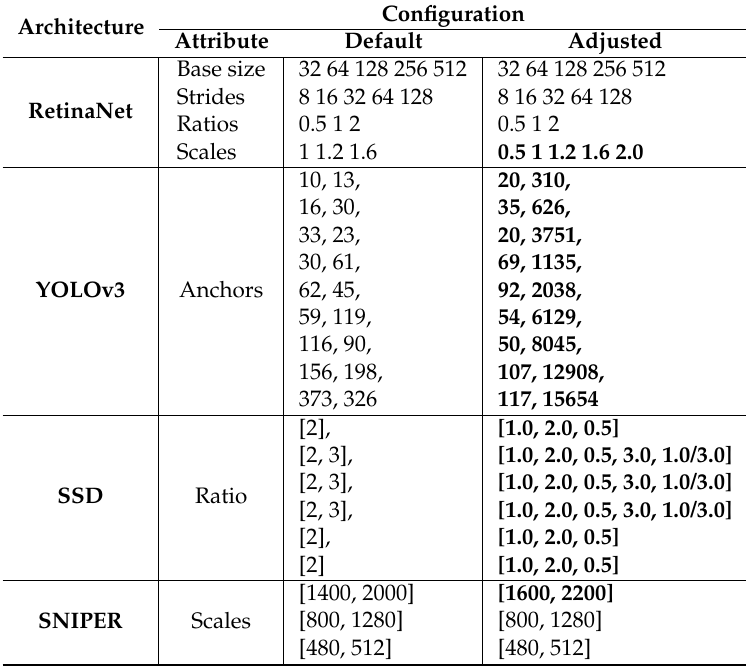
Table 1. Configuration of SNIPER, RetinaNet, YOLOv3 and